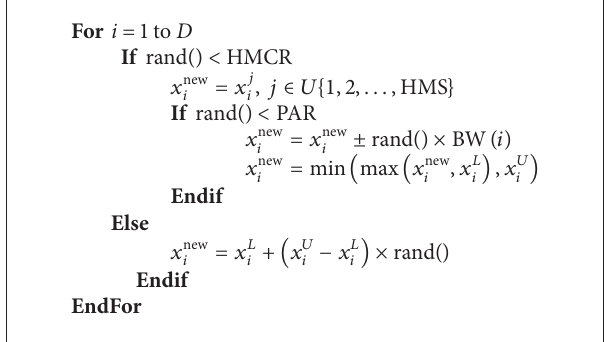
Algorithm 1: The improvisation procedure of new harmony by classical HS.